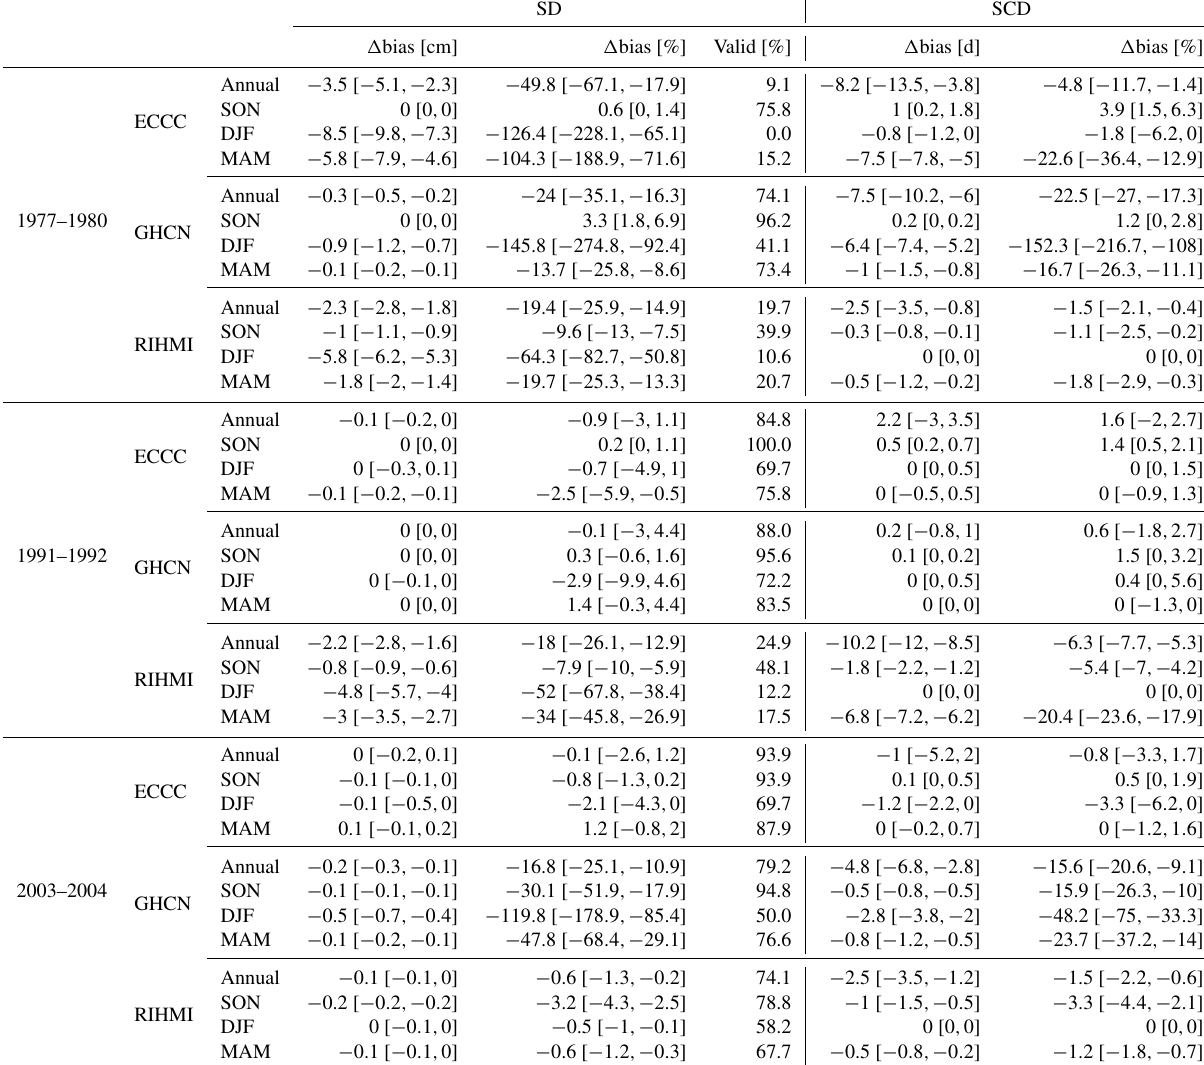
Table A1. Change in the ERA5 bias (median with its 95% CI) during 1977–1980, 1991–1992, and 2003–2004 discontinuities. The 4 years before and after the discontinuity are compared ( (cid:49) bias = bias after – bias before ). Valid [%] depicts the percentage of stations that meet the GCOS stability